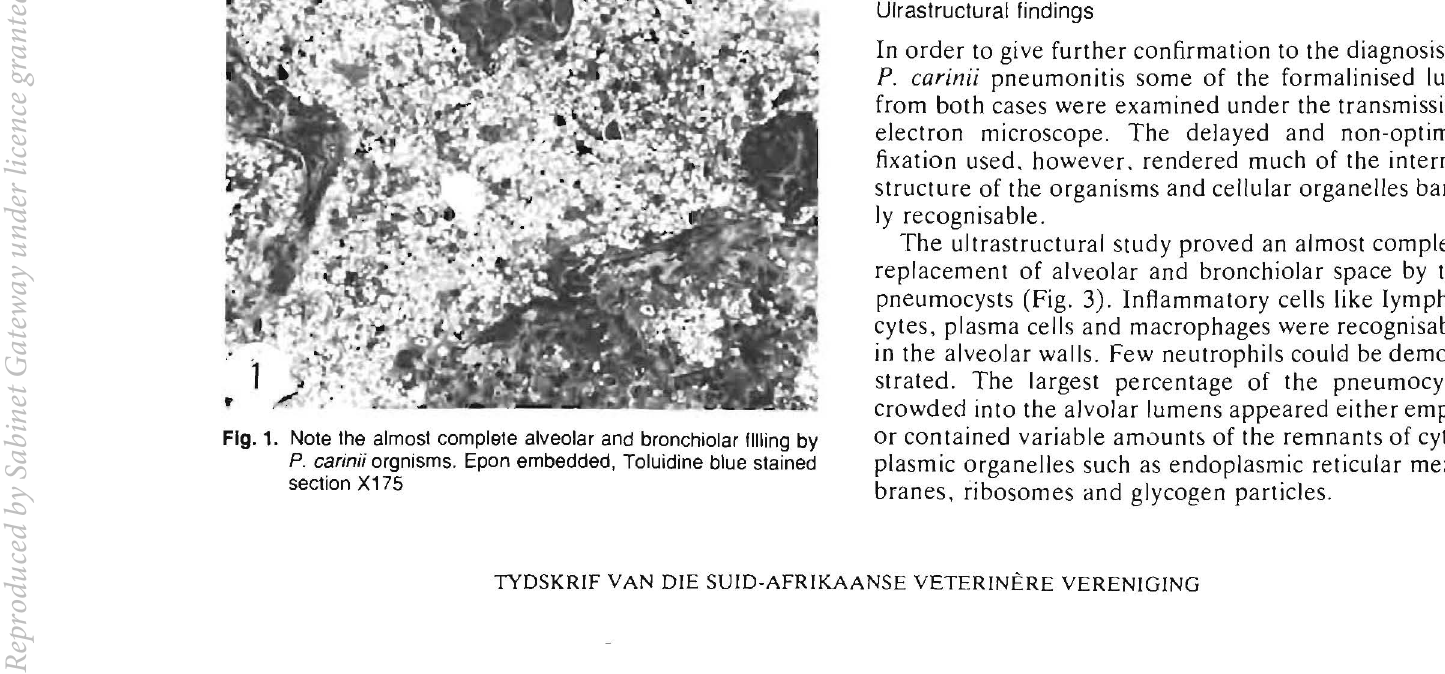
Fig. 1. Note the almost complete alveolar and bronchiolar filling by P. carinii orgnisms. Epon embedded, Toluidine blue stained section X175